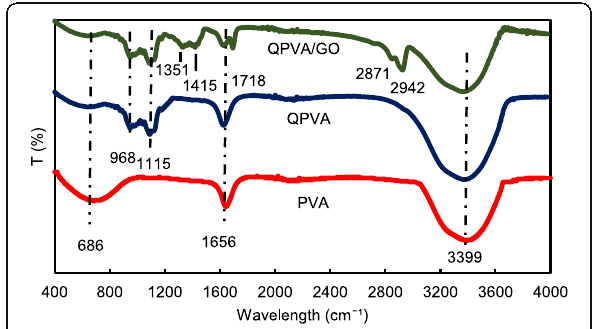
Fig. 3 FTIR spectra with wavelength 400 – 4000 cm −